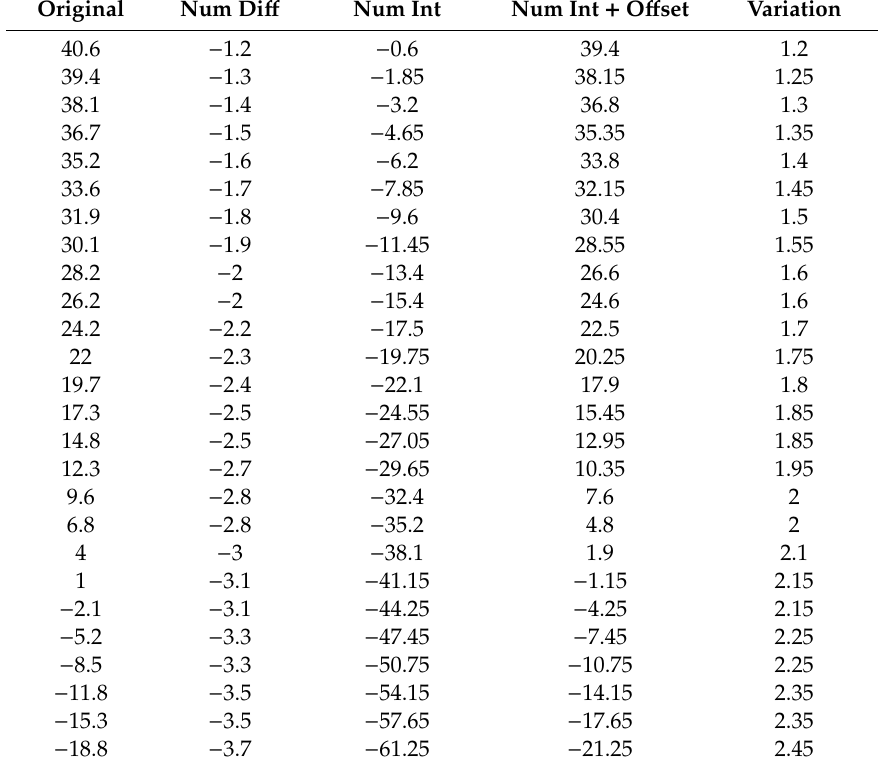
Figure 11. CW-SSIM for Channel 4 [6300:6900].